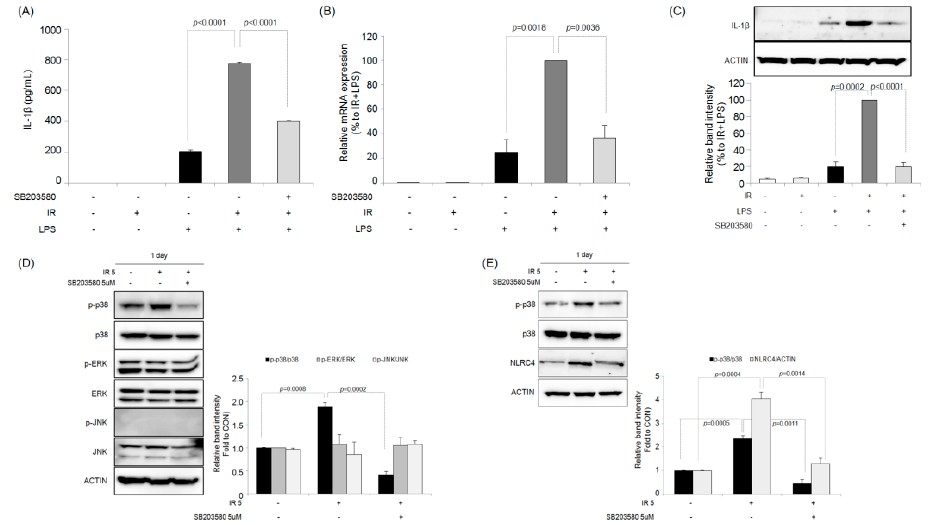
Figure 6. The p38 MAPK inhibitor SB203580 suppresses the ionizing radiation (IR)-enhanced LPS-stimulated IL-1 β production in RAW264.7 macrophages. ( A ) RAW264.7 macrophages were pretreated with ERK, JNK, and p38 MAPK inhibitors as indicated for 30 min, followed by IR (5 Gy). The cells were treated with LPS 24 h later, and IL-1 β was quantified after a further 24 h of incubation. Results are expressed as mean value ± S.E.M. The expression level of IL-1 β was analyzed using quantitative real-time PCR ( B ) and western blotting ( C ). ( D ) SB203580 inhibits the phosphorylation of p38 MAPK induced by IR in RAW264.7 macrophages. ( E ) SB203580 also inhibits the expression of NLRC4 induced by IR in RAW264.7 macrophage cells.